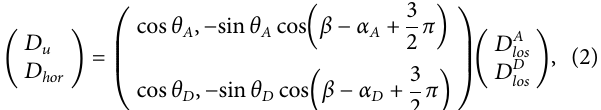
Frontiers in Environmental Science |